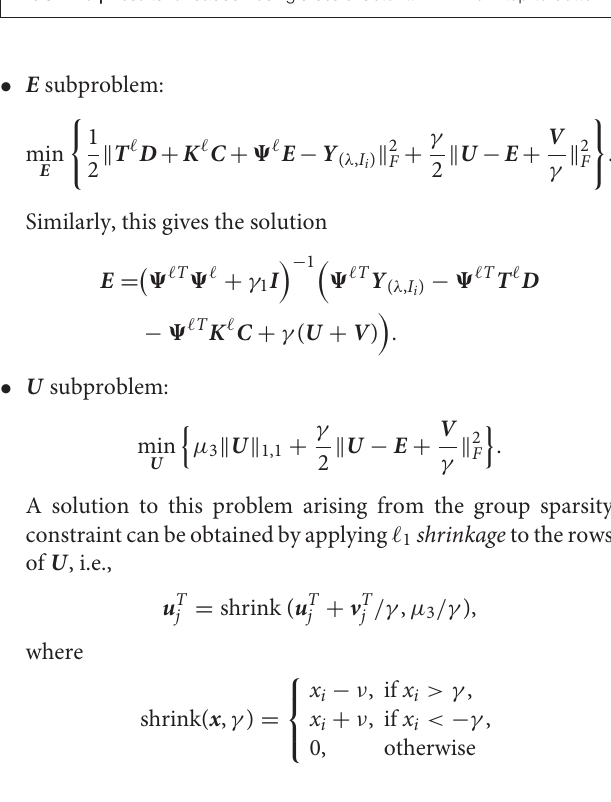
FIGURE 5 | Results for baboon using a scale factor ω = 2. From top to bottom and left to right: ground truth, bicubic interpolation, RKHS [40] and the